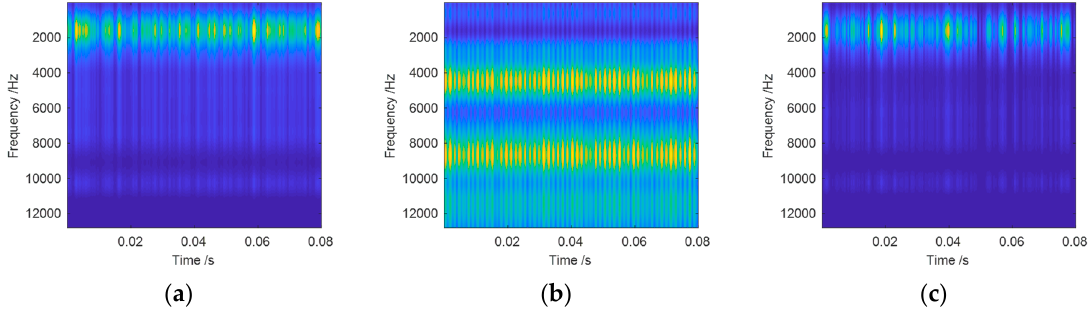
Figure 23. The reconstructed TFDs based on the SNTF factors: ( a ) Reconstructed TFD 1; ( b ) reconstructed TFD 2; ( c ) reconstructed TFD 3.